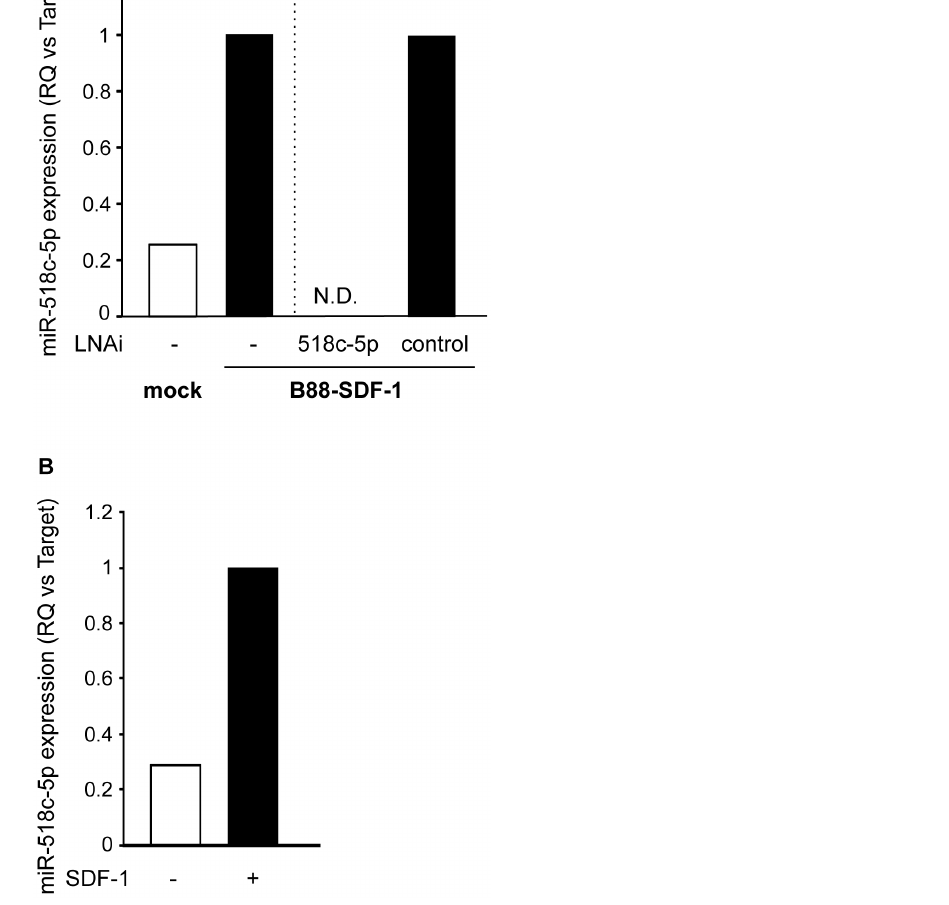
Fig. 1. The upregulation of miR-518c-5p by the SDF-1/CXCR4 system in B88 cells. (A) The expression of miR-518c-5p was confirmed in B88-mock and B88-SDF-1 cells by real-time PCR. The downregulation of miR- 518c-5p in B88-SDF-1 cells after treatment with a miR-518c-5p LNA inhibitor was also confirmed. N.D.: not detectable. (B) The expression of miR-518c-5p was confirmed in parental B88 cells after treatment with or without SDF-1 by real-time